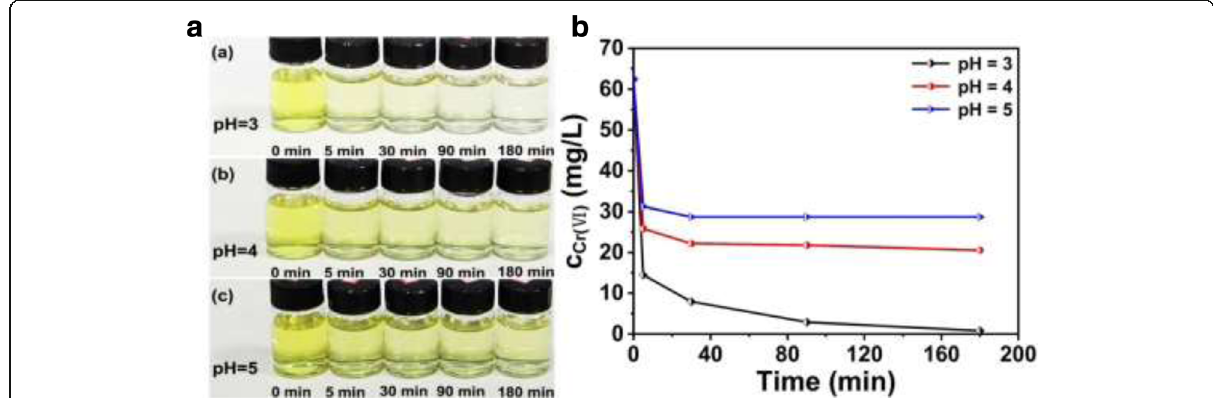
Fig. 3 The Cr (VI) solution after treated with hollow PANI micro/nanospheres in different times, solution pH respectively at a 3, b 4, and c 5 (initial Cr (VI) concentration: 1.2 mmol/L (62.4 mg/L)). a The photographs and b Cr (VI) concentration in the final